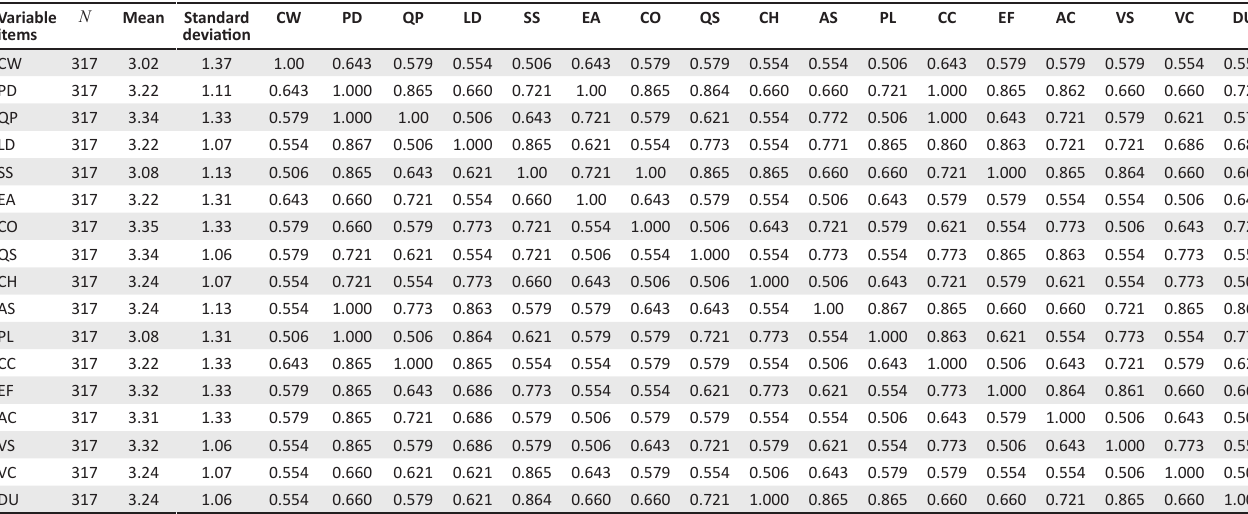
TABLE 2: Descriptive statistics and correlation matrix. N Mean Standard Variable items